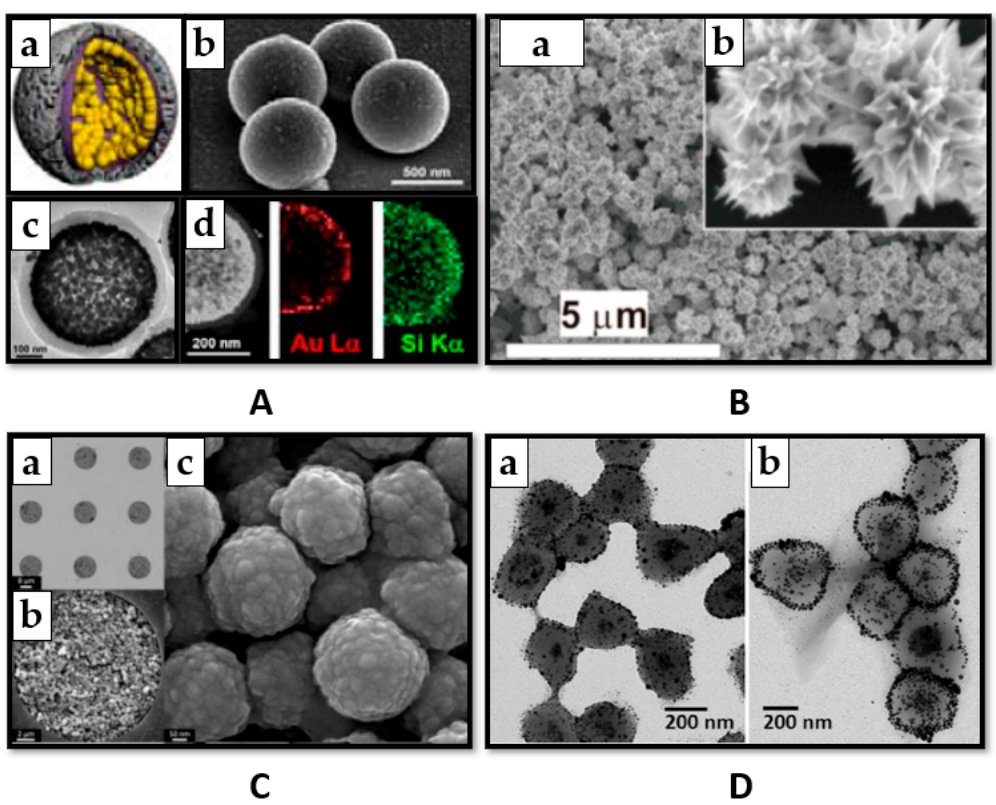
Figure 2. Strategies for increasing the electromagnetic surface enhanced Raman spectroscopy (SERS) enhancement. ( A ) ( a ) Schematic illustration of the capsule; ( b , c ) Representative TEM micrographs of the capsules; ( d ) STEM/XED analyses of the capsule composition. Reproduced with permission of [42]. Copyright John Wiley and Sons, 2019. ( B ) ( a ) FESEM image of the chestnut-like Au nanocrystal film, ( b ) local magnified image. Reproduced with permission of [19]. ( C ) ( a – c ) SEM images of F-NPs substrate with 100 nm of Ag coating film. Reproduced with permission of [47]. Copyright IOP publishing, 2020. ( D ) Representative TEM images of ( a ) the Fe 3 O 4 @pNIPAM nanohybrid materials containing Ag seeds; ( b ) the finalFe 3 O 4 xAgNPs@pNIPAMcomposite microgels. Reproduced with permission of [50]. Copyright American Chemical Society, 2011.